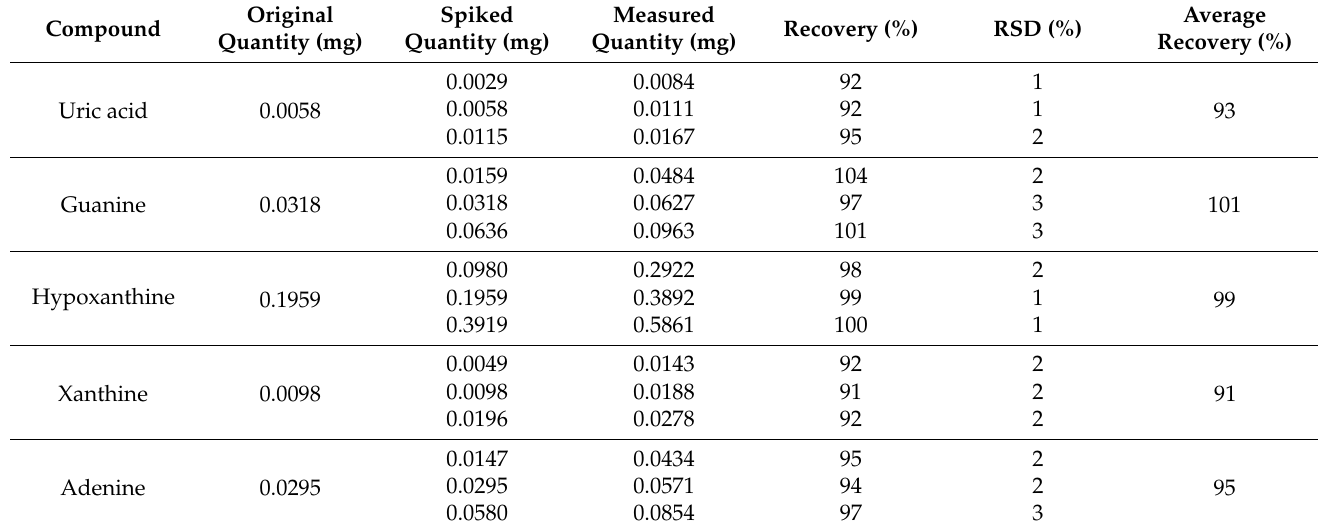
Table 4. Recoveries of four purines and uric acid ( n =